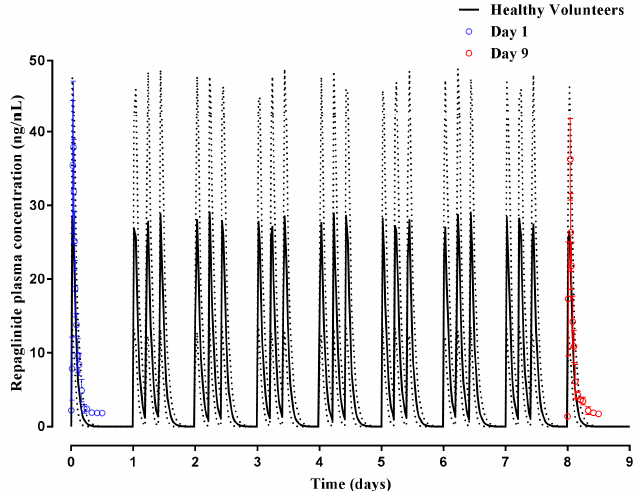
Figure 5. Simulated plasma concentration–time profile of repaglinide following single and multiple doses in healthy adults. An oral dose of 2 mg was administered once daily on day 1, and thereafter daily for nine days to healthy adult volunteers ( n = 12). Solid lines represent mean predictions with dotted lines representing the 5th and 95th percentile ranges. Open circles represent data for the observed study at day 1 (single dose) and day 9 (multiple-dosing) [43].